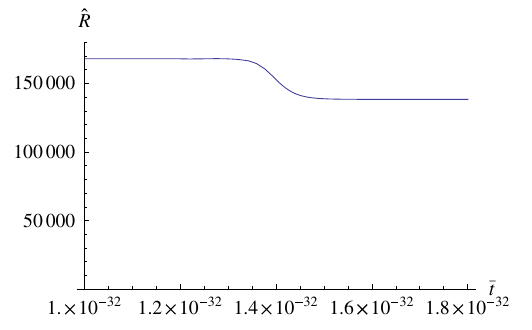
Fig. 7 The diagram presents the evolution of the Ricci scalar ˆ R with respect to the cosmological time ¯ t . The time is expressed in seconds and . The value of the parameter the Ricci scalar ˆ R is expressed in km 2 s 2 Mpc 2 γ is assumed as 3 . 277 × 10 − 6 s 2 Mpc 2 = . We also assume that Λ km 2 3 H 2 0 0 . 6911, where H 0 = 67 . 74 km . The transition phase is of logistic-like s Mpc behaviour and is strictly correlated with a peak of the matter density, as shown in Fig.